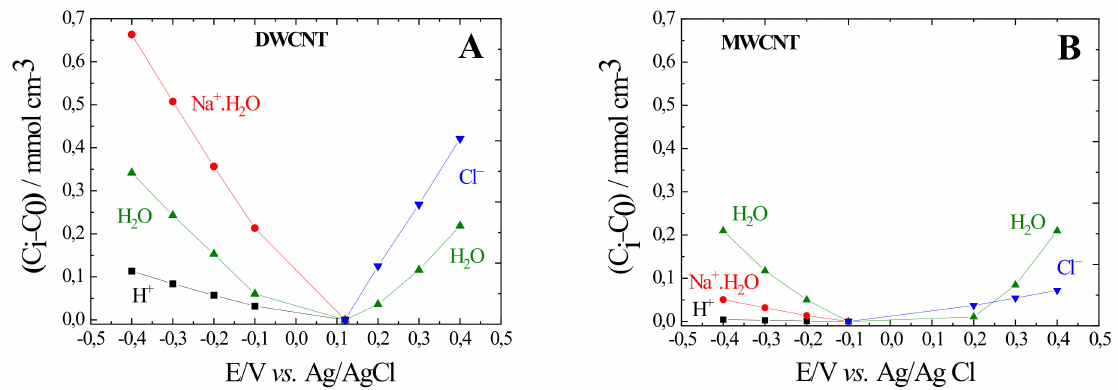
Figure 6. Evolution of the relative concentration, C i –C 0 , for DWCNT ( A ), MWCNT ( B ) of the charged and non-charged species over the applied potential and measured in aqueous 0.5M